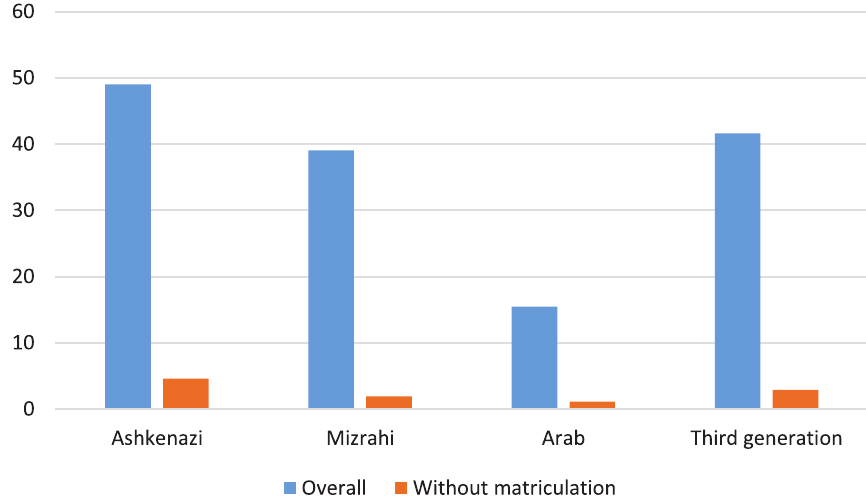
Figure 1. Academic enrolment by ethnic group, overall and without a matriculation diploma at high school’s